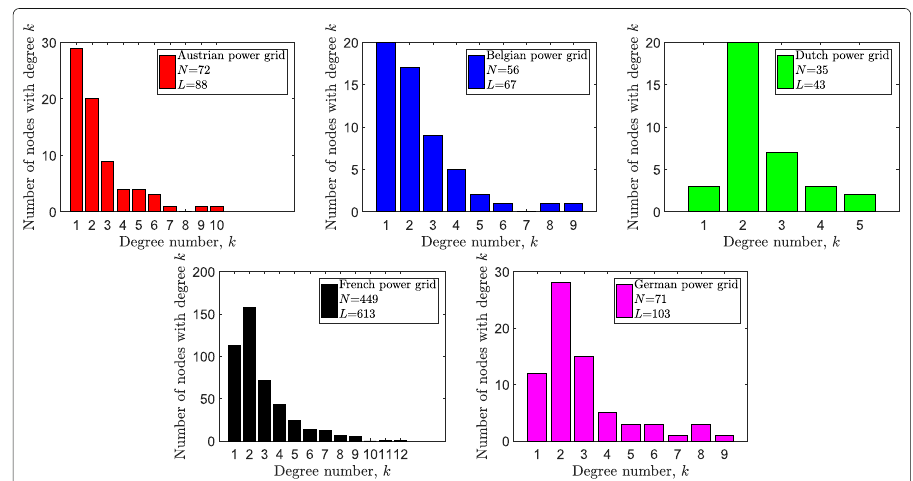
Fig. 1 The degree distribution of the simple graphs of 5 European power